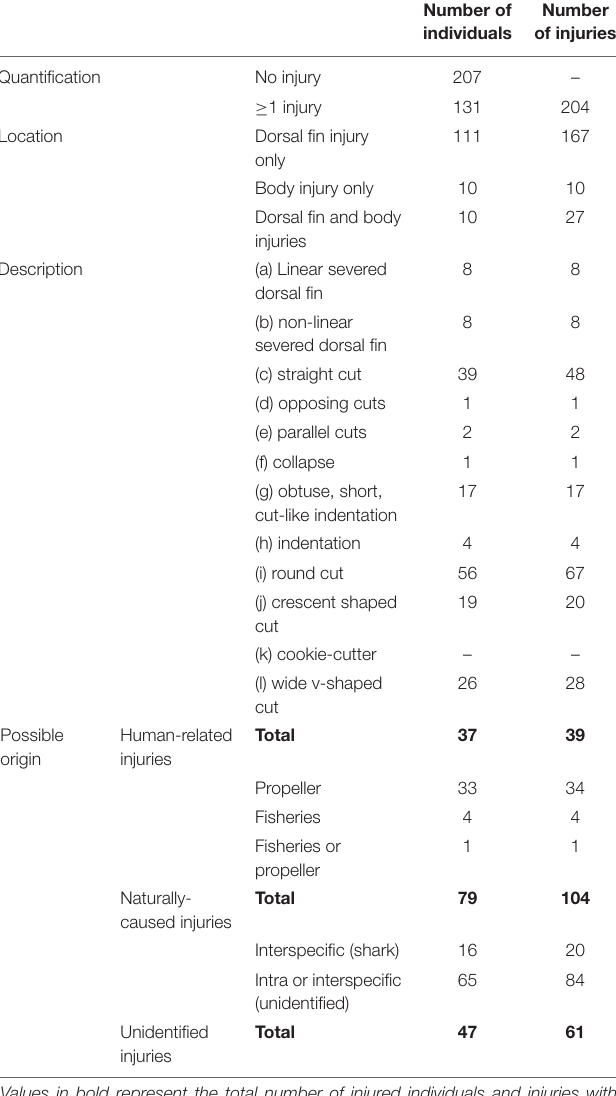
TABLE 3 | Quantification of external injuries following (Luksenburg, 2014) in Indo-Pacific bottlenose dolphins photo-identified in the southern range of New Caledonia between 1997 and